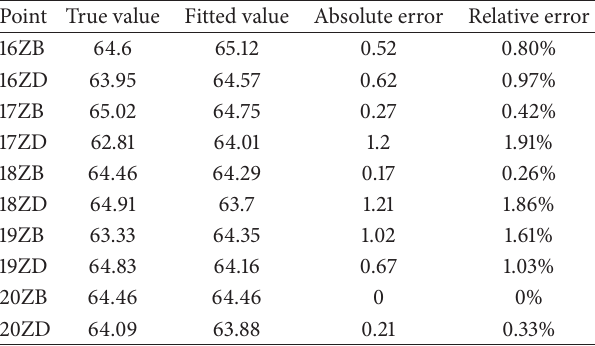
Table 5: The error analysis of the 45 groups table of chairs training